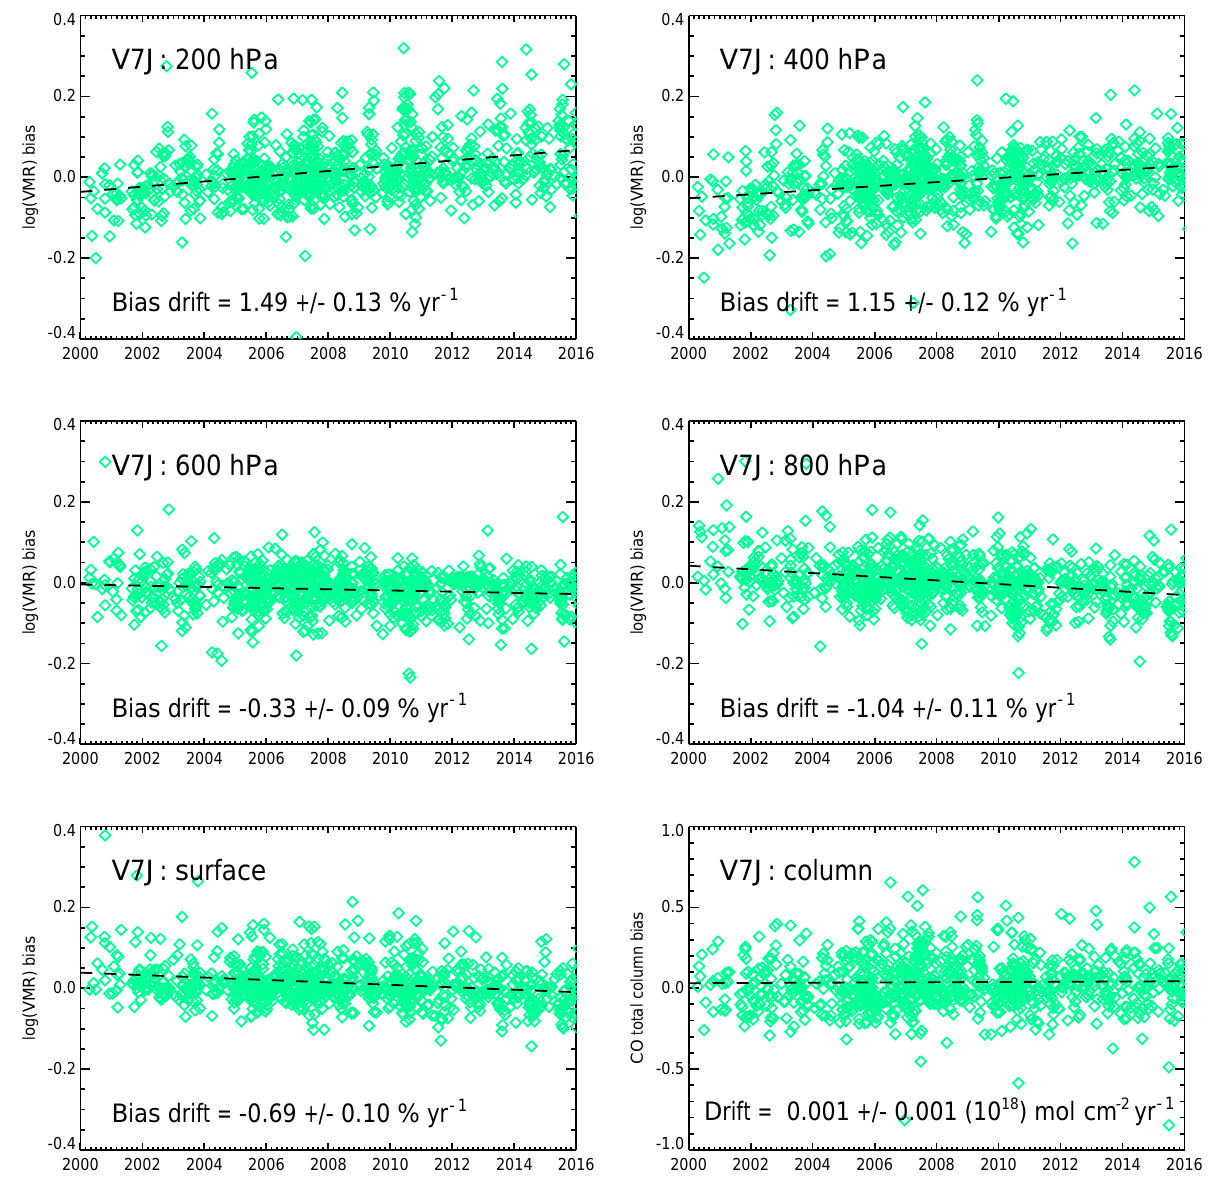
Figure 16. Retrieval bias drift for V7 TIR-NIR products based on the NOAA flask measurements. See caption to Fig.